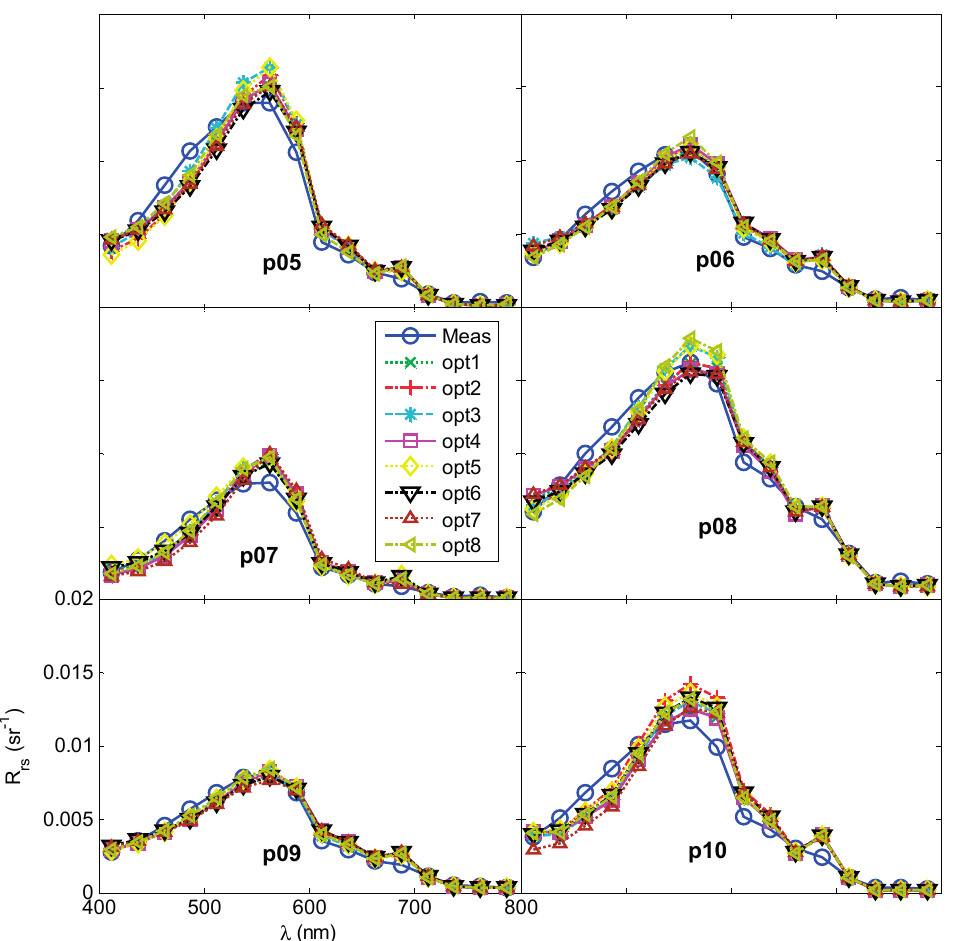
Figure 6. Remote sensing reflectance (16 bands) for the six sampling points p05–p10. Blue circles: measured. Rest: Results of the eight optimizations, whose outcome parameters are shown in Table